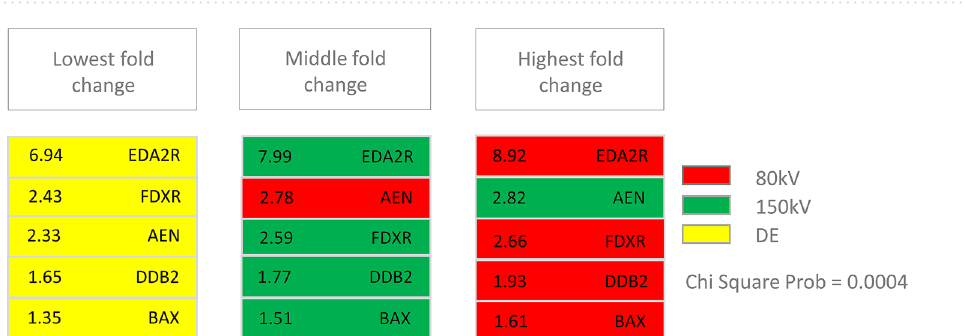
Figure 3. Venn diagram summarizing the number of differentially expressed genes identified by direct comparison of 80 kV single-energy CT (SECT), 150 kV SECT and dual-energy CT (DE), respectively. The corresponding gene lists can be found in Supplementary Table S2.